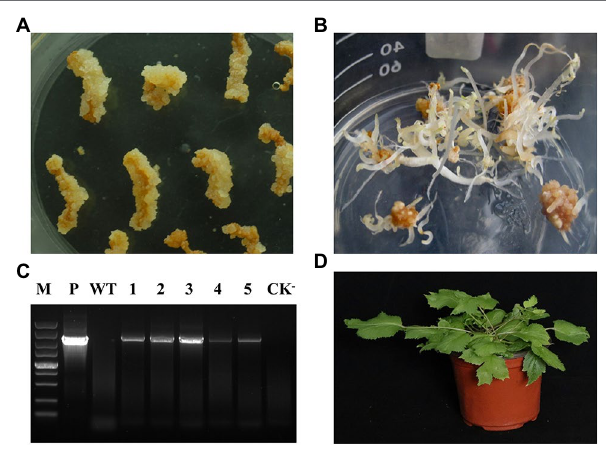
FIGURE 6 | Establishment systems of the propagation and gene information of Aralia elata . (A) The induction of the somatic embryogenic callus from the root in the 1/2SH medium with 3.0 mg/L of IBA and 0.2 mg/L of KT for 3-week culture. (B) The somatic embryogenesis from that callus in the 1/2SH medium with 1.0 mg/L of IBA and 0.2 mg/L of KT for 3-week culture. (C) Introduction of the exogenous genes in the plant. P, positive control; The WT was not transformed with Agrobacterium ; 1–5, the transgenic plant with target gene; CK − , negative control. (D) The somatic embryo plant of gene